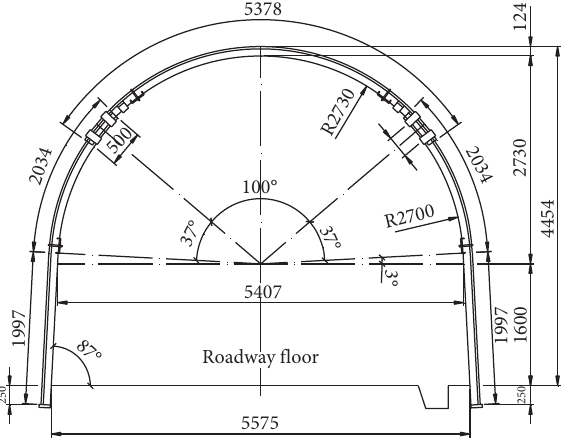
Figure 1: Schematic diagram of supporting in the no. 6 uphill coal floor return